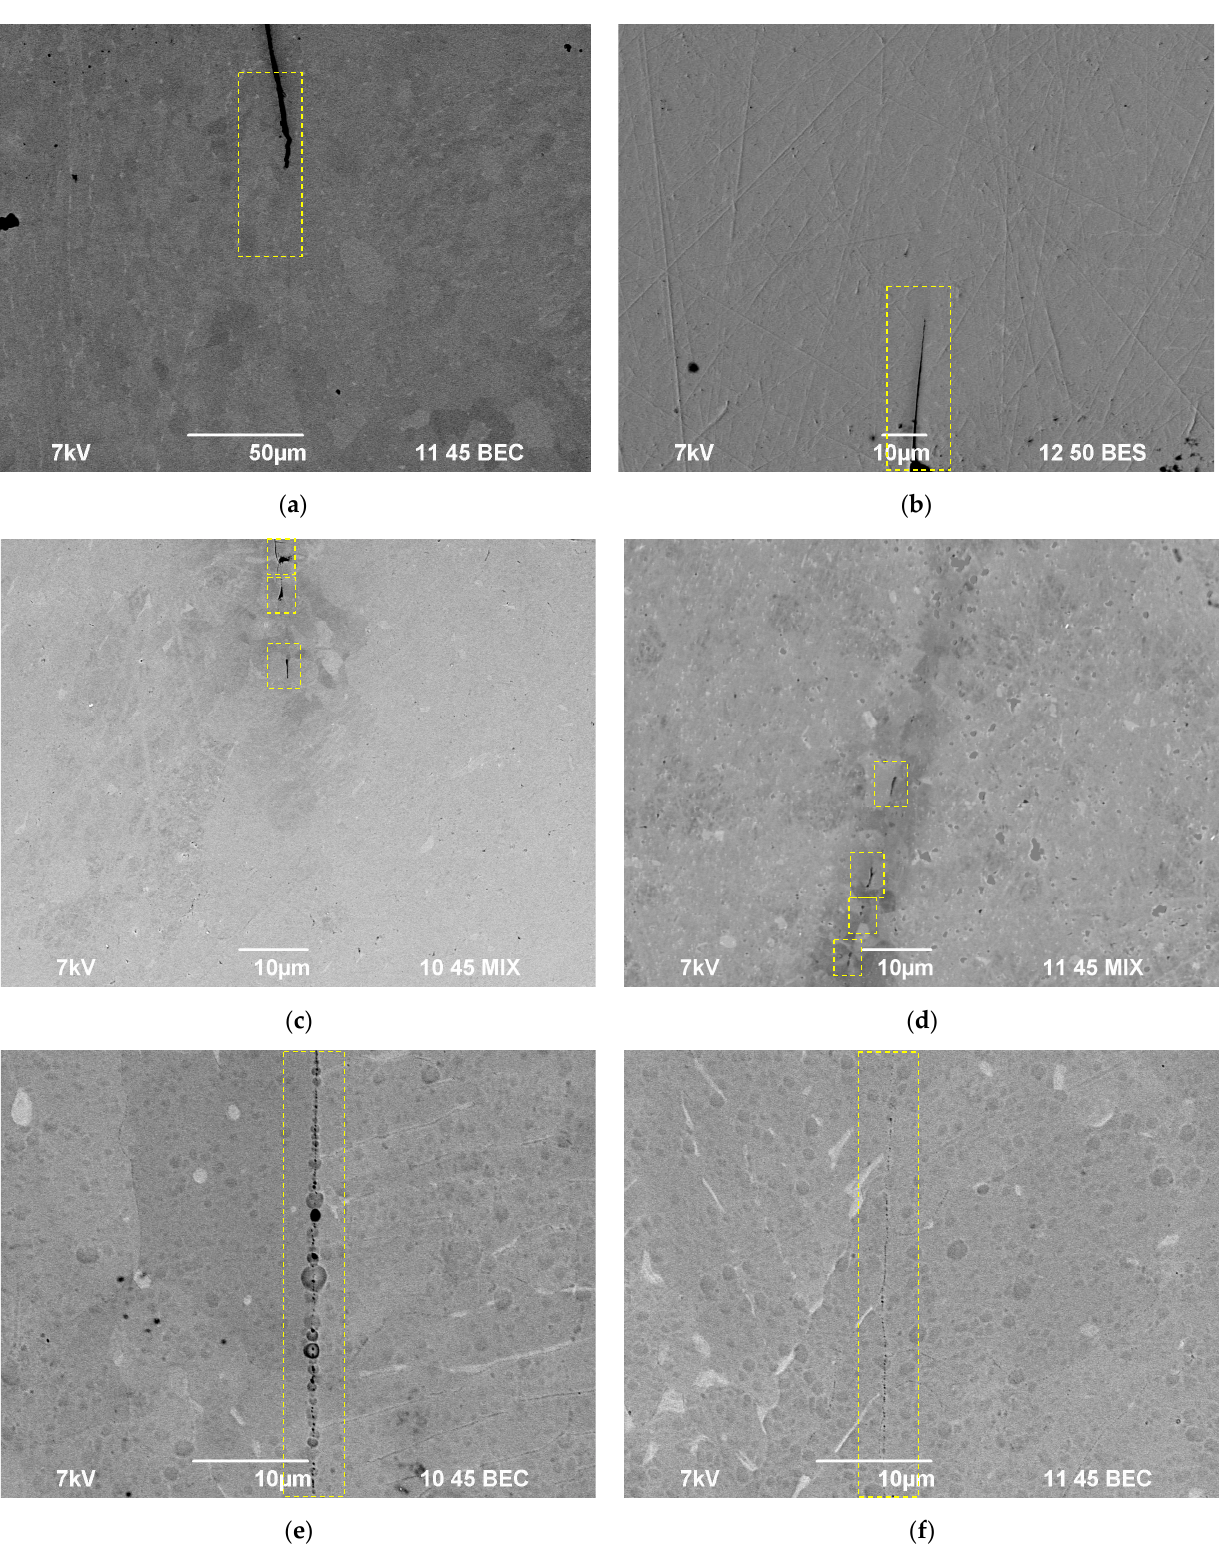
Figure 6. Typical defects in the welded joints of the coarse-grained ( a , c , e ) and UFG ( b , d , f ) alloy after the di ff usion welding (V h = 50 °C/min, T = 800 °C, t = 10 min): ( a , b ) a joint defect, ( c , d ) a macropore, ( e , f ) a micropore. SEM.